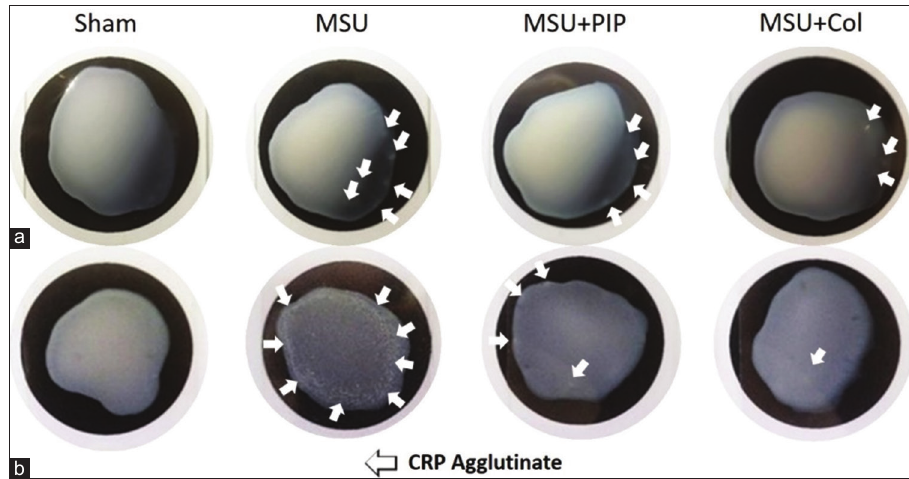
b Fig ure-6: Effect of piperine in reducing C-reactive protein (CRP) in the liver due to monosodium urate-induced inflammation. Detection was carried out based on the agglutination of the 10% liver homogenate supernatant on CRP-latex. (a) Protocol I (preventive) rat liver CRP agglutinate. (b) Rat liver CRP agglutinate protocol II (curative).